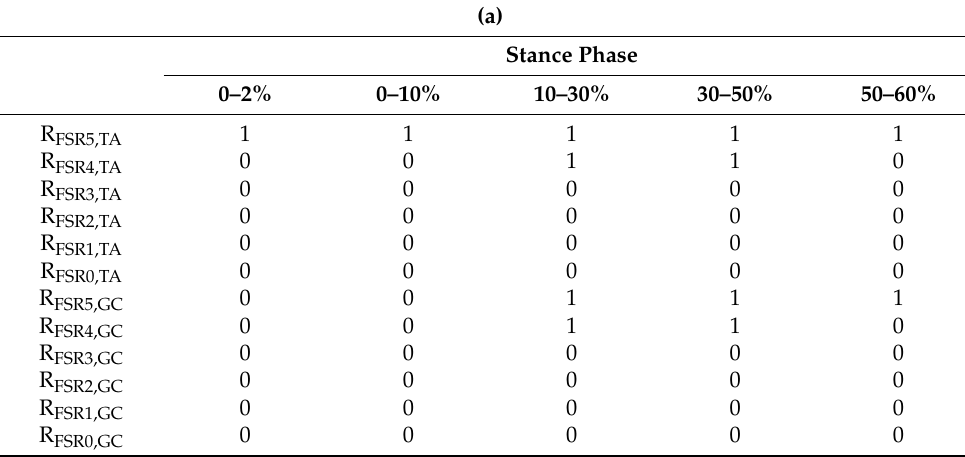
Figure 24. It should be noticed both defective walking patterns were reproduced by the healthy volunteer for illustration purpose. Both are described as follows. Table 7. The gait map for the stance phase for ( a ) heel walking, and ( b ) toe